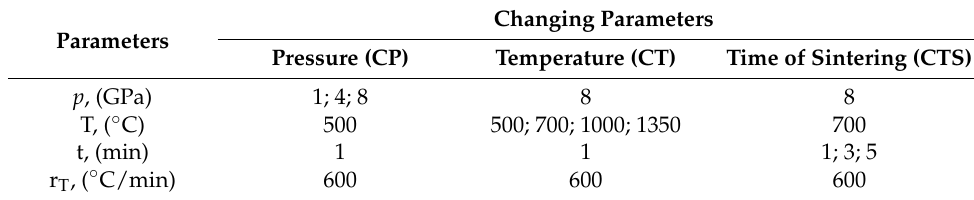
Figure 2. Schematic presentation of the toroidal high-pressure cell. Table 2. Parameters for the optimization of the sintering process.